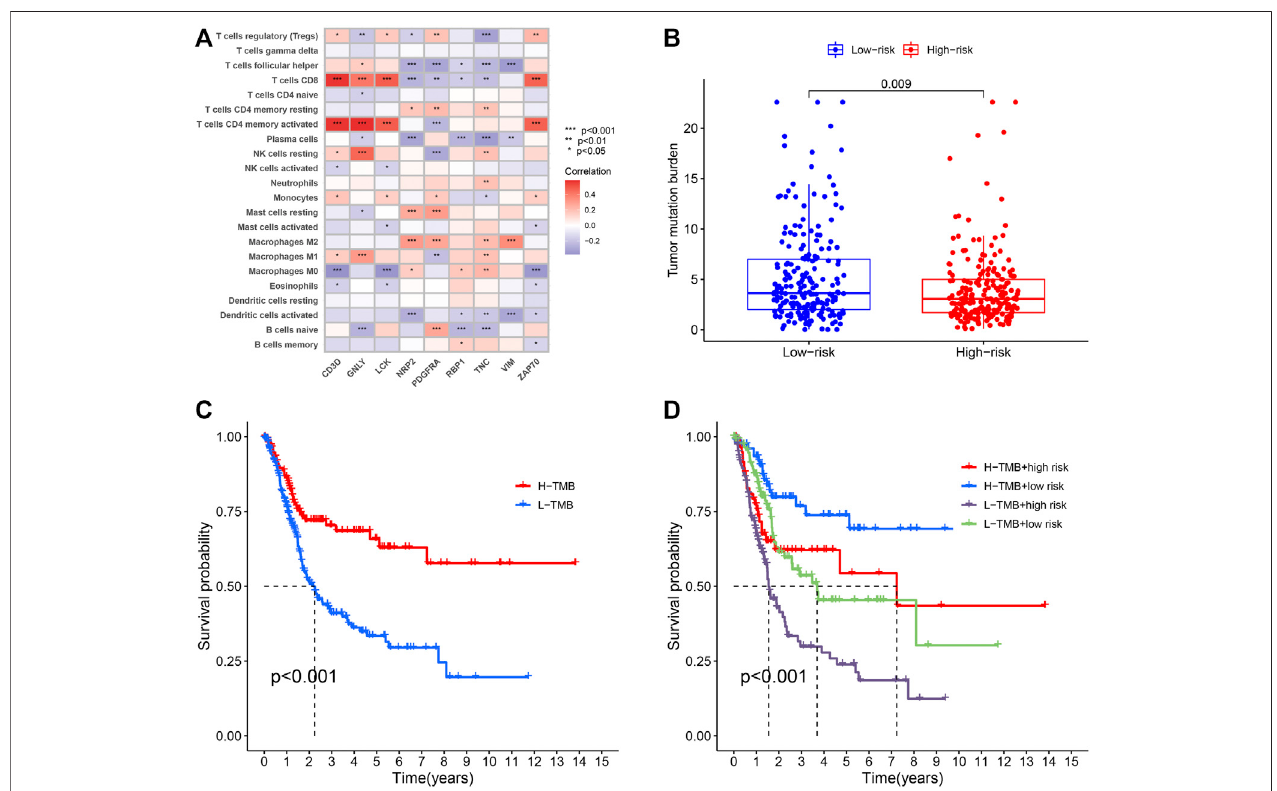
FIGURE4|(A) Heatmap showing thecorrelation oftheprognosticmodel ofBLCA (PMB)-basedrisksignaturewithimmune cellin fi ltration.Thered suggestingthe positive correlation while blue suggesting the negative correlation. (B) The comparison of TMB between High- and low-risk groups. (C) Kaplan-Meier survivalanalysisof the TMB in the TCGA-BLCA cohort. (D) Kaplan-Meier survival analysis of four groups strati fi ed by combining the TMB and the PMB-based risk signature in the TCGA- BLCA